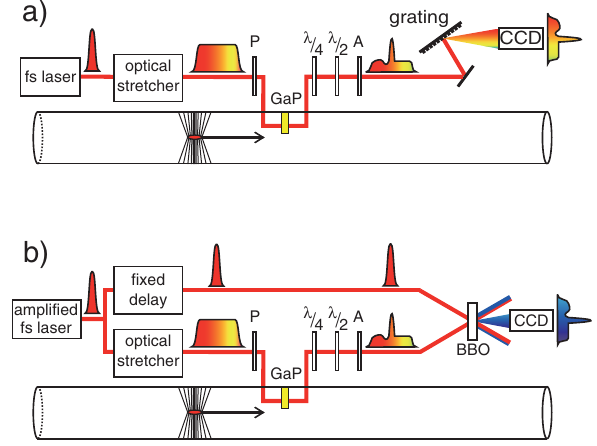
FIG. 5. (Color) Schematic drawing of the setup for (a) electro- optic spectral decoding (EOSD) and (b) electro-optic temporal decoding (EOTD). Optical components are labeled as P (polar- izer), A (analyzing polarizer), (cid:3)= 4 (quarter-wave plate), (cid:3)= 2 (half-wave plate), GaP (electro-optic GaP crystal), and BBO (second-harmonic BBO crystal).